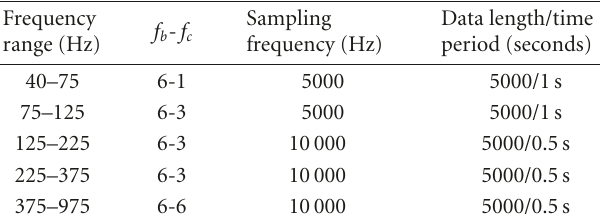
Table 7: Settings of the proposed detection